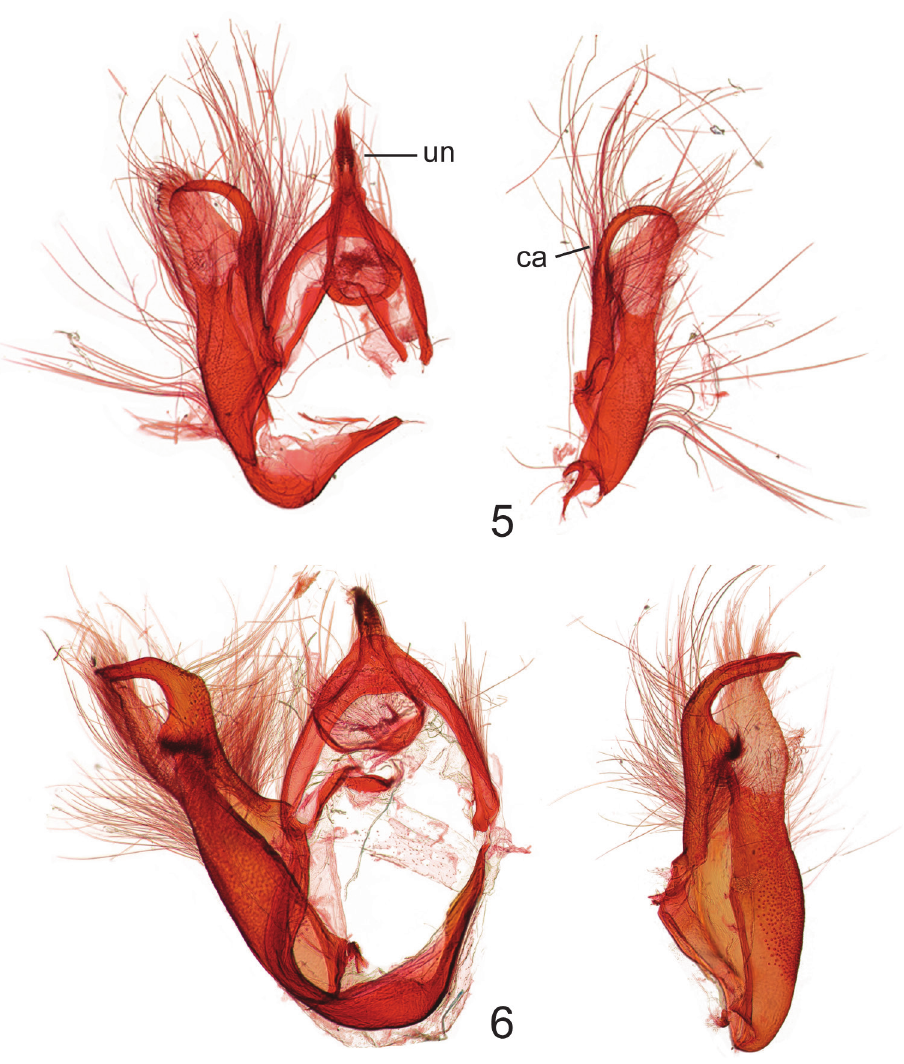
Figures 5–6. Male genitalia of Gadirtha species; un uncus ca costal arm of valve. 5 Gadirtha fusca sp. n. 6 Gadirtha impingens and expanded ventrally to basitarsus, tarsi black dorsally, a few brown scales laterally, white ventrally; metathoracic tibia cream colored, tarsi cream colored with black basal bands on segments 2–4. Forewing length 18.5–22.4 mm; ground color brownish gray; varying amounts of indistinct rufous areas distributed over forewing; costa with rectan- gulate dark gray basal spot and a fainter dark gray triangulate spot proximal to apex; antemedial line black, very thin, angulate from R vein to anal vein; medial line absent; orbicular spot obscure, a round area consisting of a few pale scales bordered either dis-